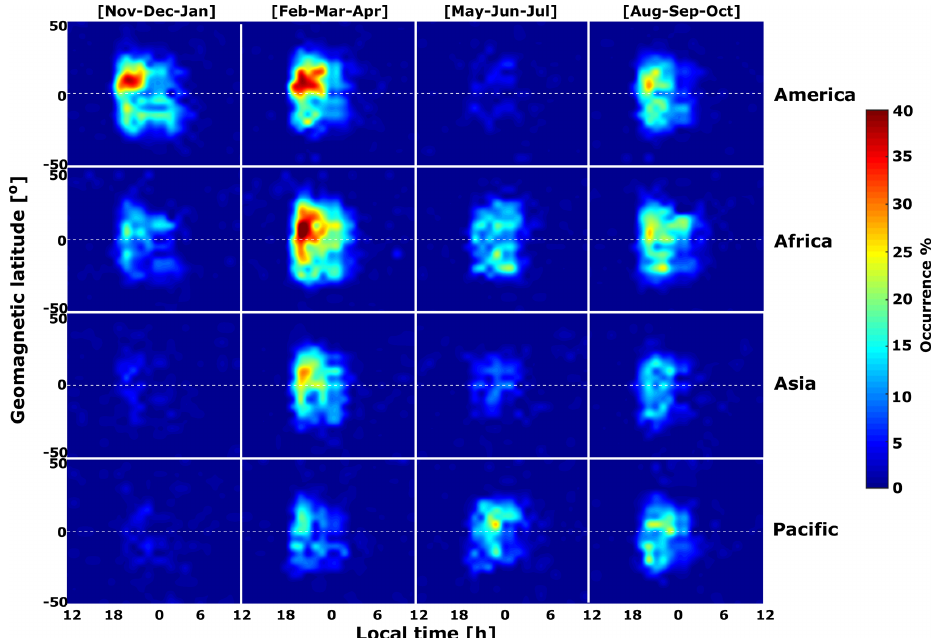
Figure 6. EPB occurrence during the years 2012–2016 for different longitude sectors (regions) based on 3-month intervals (seasons) within 5 ◦ geomagnetic latitude by 01:00LT in the bin. White dashed lines represent the geomagnetic dip